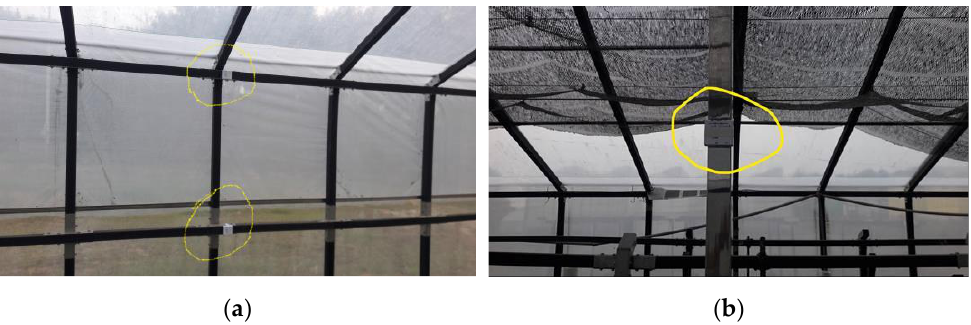
Figure 9. ( a ) Location of accelerometers on the gable frame; ( b ) location of accelerometer on the central stainless column. central stainless